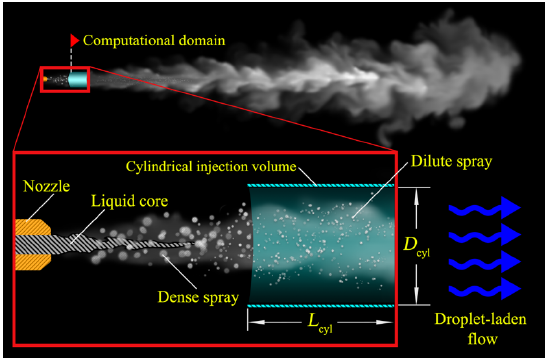
Figure 1. Artistic illustration of the cylindrical injection volume